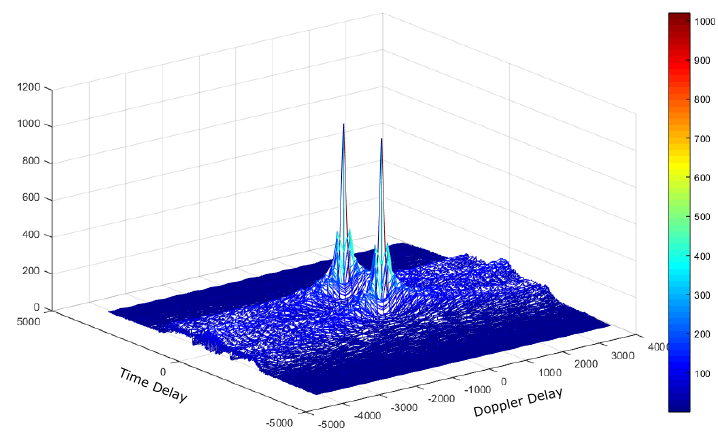
Figure 20. Two closer scatterers using chirp pulses (MMPP), with no noise.